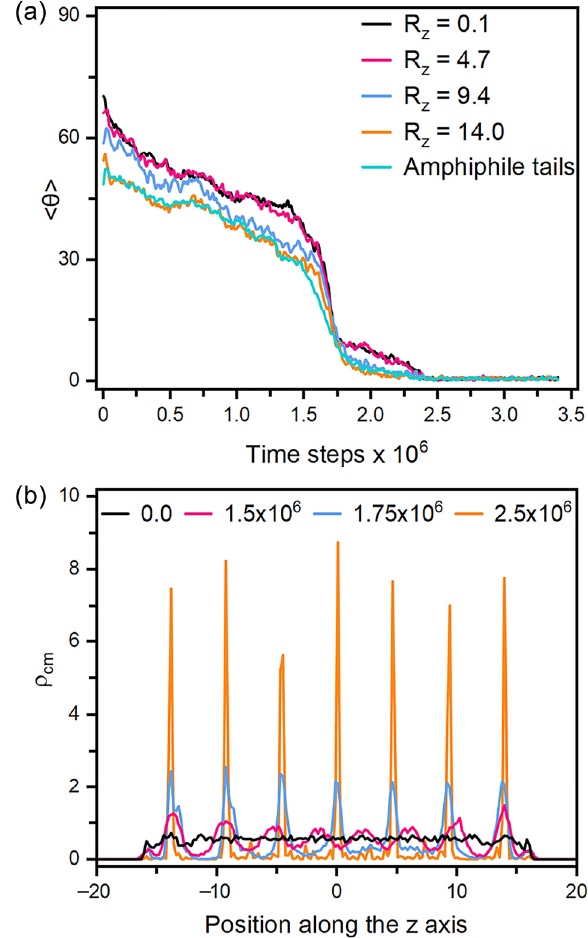
Figure 7. ( a ) Time evolution of the tilt angle for the mesogens in each smectic layer along the z axis and the amphiphile tails when directly cooling a tilted configuration with ρ s = 0.4 and T = 0.6 to the homeotropic smectic anchoring at T = 0.3, and ( b ) the density distributions for the center of mass of mesogens in four instantaneous configurations of the above process at t = 0.0, 1.5 × 10 6 , 1.75 × 10 6 and 2.5 × 10 6 time steps. Instantaneous snapshots of six representative configurations in this reorientation process are displayed in Figure S3.